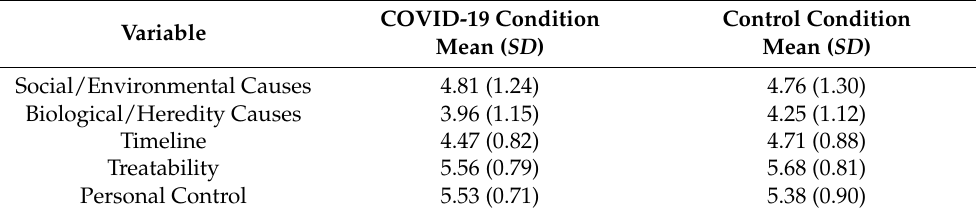
Table 2. Descriptive statistics across experimental conditions in Study